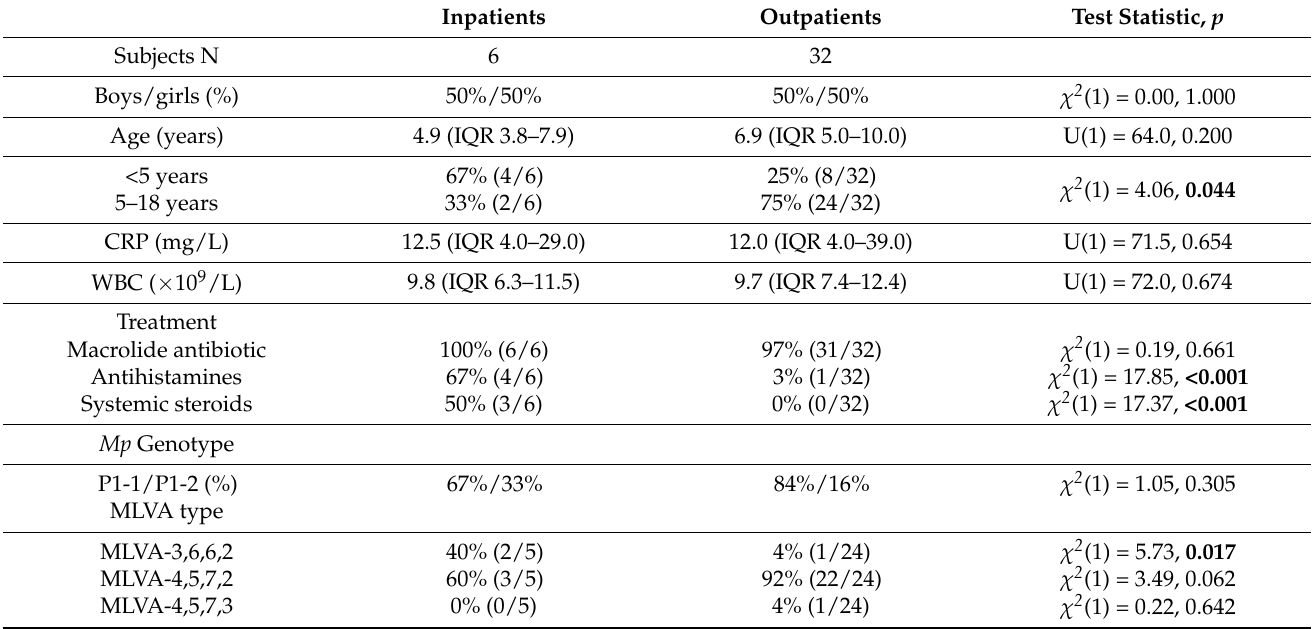
Table 5. Comparison of characteristics of patients admitted to the hospital because of cutaneous disease to the outpatients’ ones. Data are presented as median (IQR) or as percentage (proportion of subjects). Significant differences ( p < 0.05) are highlighted in bold.